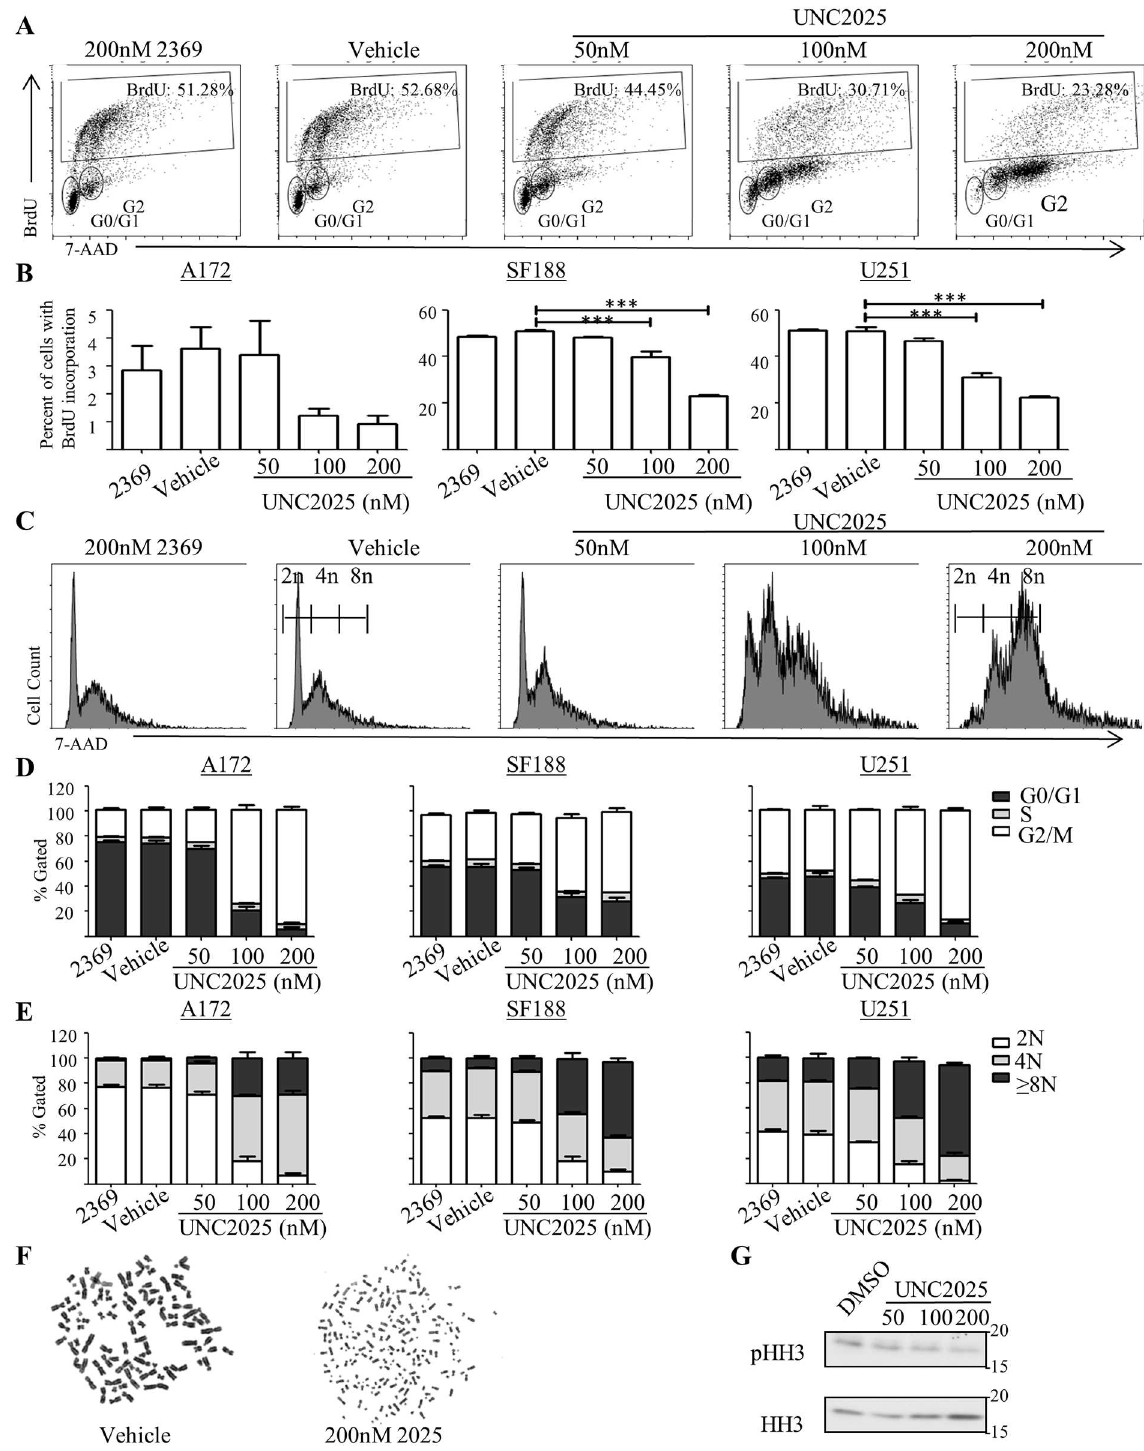
Fig 3. UNC2025inhibits proliferation and induces polyploidy in GBM cells. A172, SF188, and U251 cells were treated with the indicatedconcentrations of UNC2025,200nM UNC2369(a negative control TKI), or vehicle (DMSO) for 48 hours. (A-C) BrdU was added to the culture medium four hours prior to harvest and cells were fixed, and stained with a fluorescent anti-BrdU antibody and propidium iodide,prior to analysis by flow cytometry. (A) Representative flow cytometry plots showingBrdU incorporation in the U251 cell line. (B) Quantitationof BrdU incorporation. Mean values and standard errors derivedfrom 3 independent